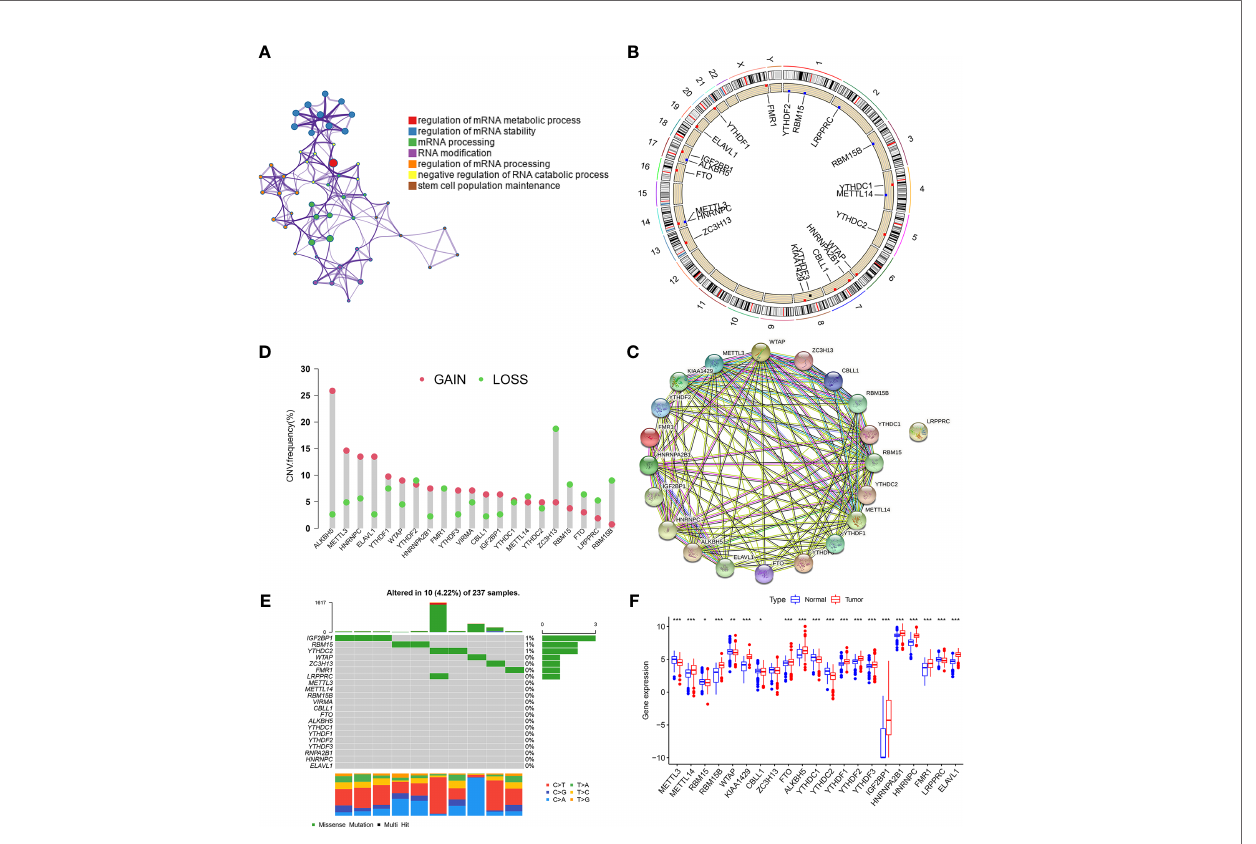
FIGURE 1 | Landscape of m6A regulators in STS. (A) GO enrichment plot showing seven important terms related with m6A regulators. (B) The location of CNV alteration of m6A regulators on 23 chromosomes in TCGA-SARC cohorts. (C) The CNV variation frequency of m6A regulators in TCGA-SARC corhort. The height of the column represented the alteration frequency. Green dot and red dot represented the deletion frequency and the ampli fi cation frequency, respectively. (D) The protein-protein interactions between 21 m6A regulators. (E) The mutation frequencies of m6A regulators in TCGA-STS cohort. Each column represented an individual sample. The upper barplot showed tumor mutation load and the number on the right indicated the mutation frequency in each regulator. (F) The expression of 21 m6A regulators between normal tissues from Genotype-Tissue Expression samples and STS tissue from TCGA-SARC cohort. The statistical difference was compared through the Kruskal – Wallis test. *P < 0.05; **P < 0.01; ***P <